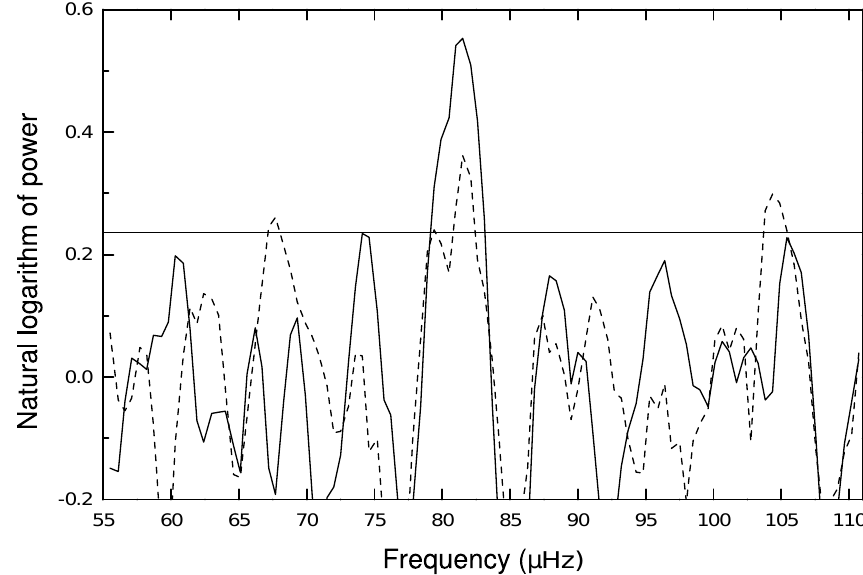
Fig. 4. As for Fig. 3 but for the 2.5 − 5-h period subrange and spring